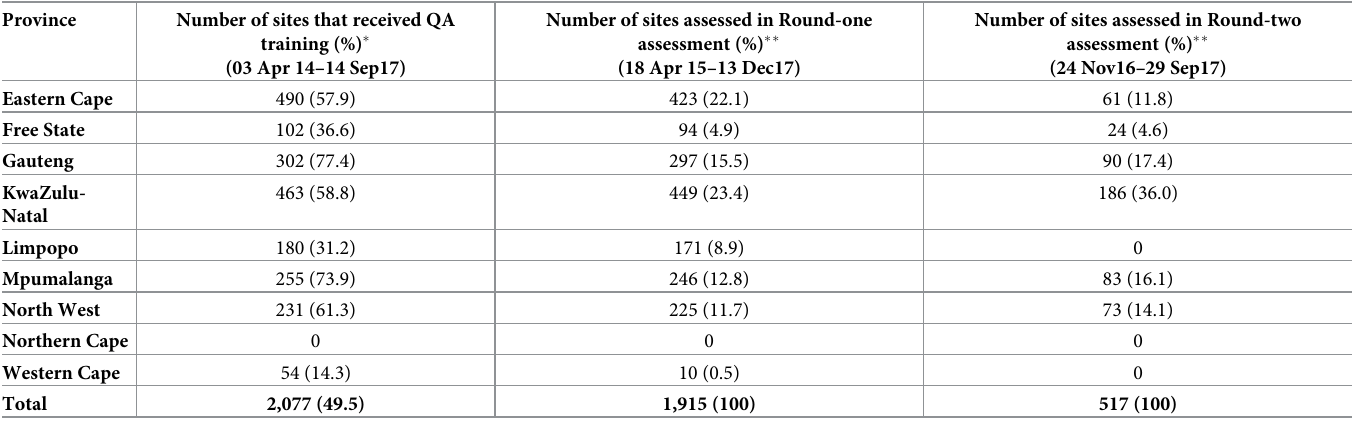
Table 1. Distribution of HIV testing sites by province enrolled in RTCQI in South Africa, 2014–2017.